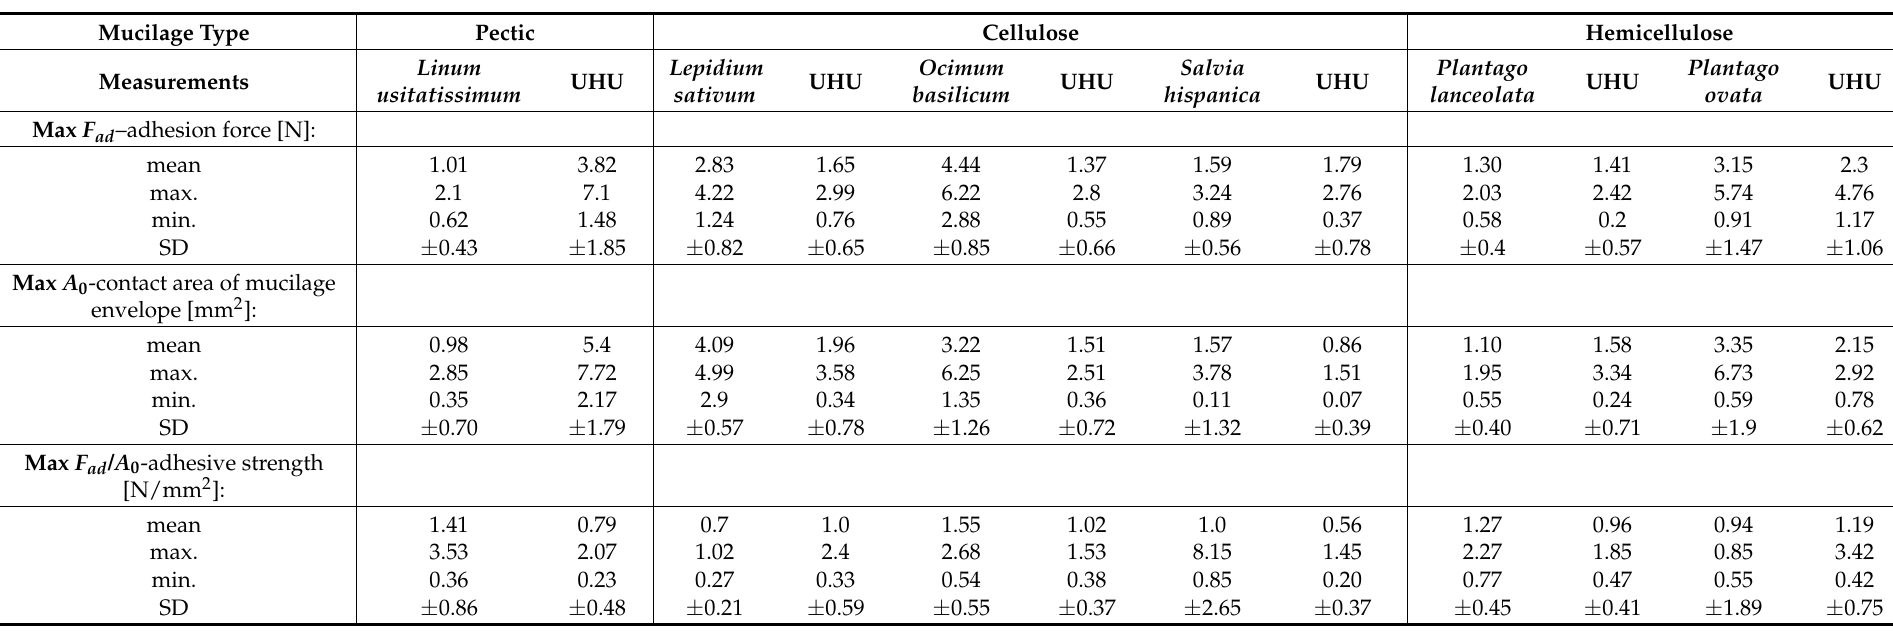
min. 0.35 2.17 0.78 SD ± 1.32 ± 0.39 ± 0.40 ± 0.71 ± 1.9 ± 0.62 Max F ad / A 0 -adhesive strength [N/mm 2 ]: mean